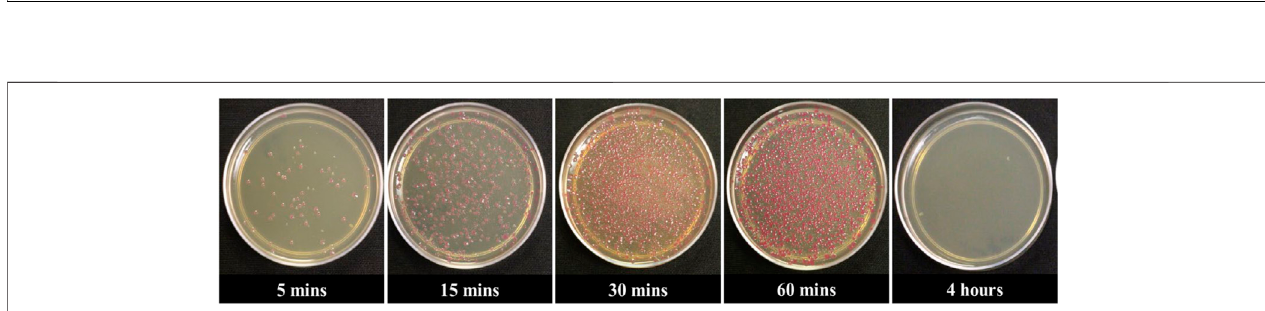
Frontiers in Nanotechnology |